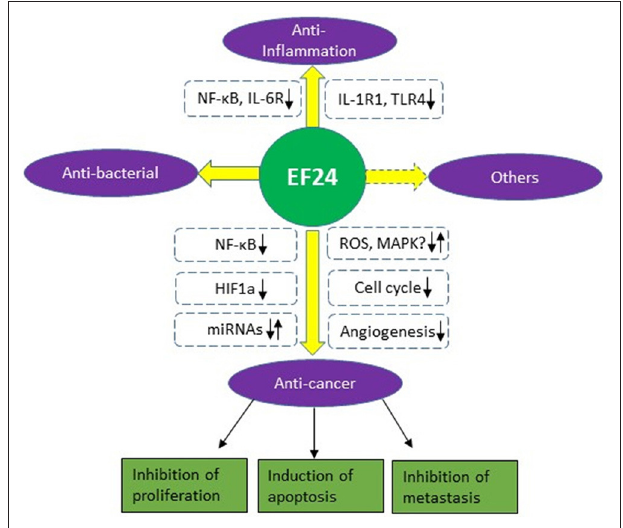
FIGURE 2 | Biological activities and mechanisms of